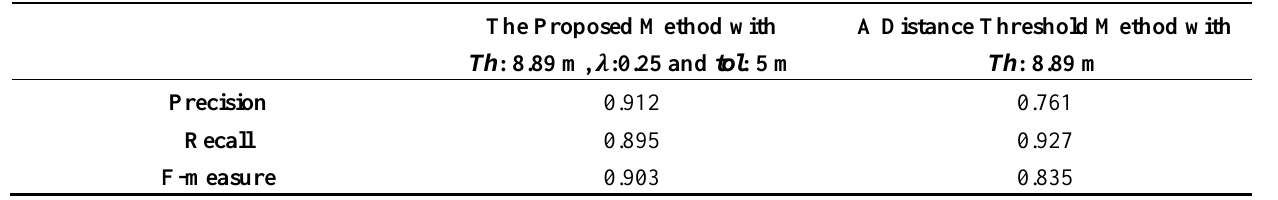
Table 1. The statistical evaluation of the proposed method and a distance threshold method in the test area in Figure